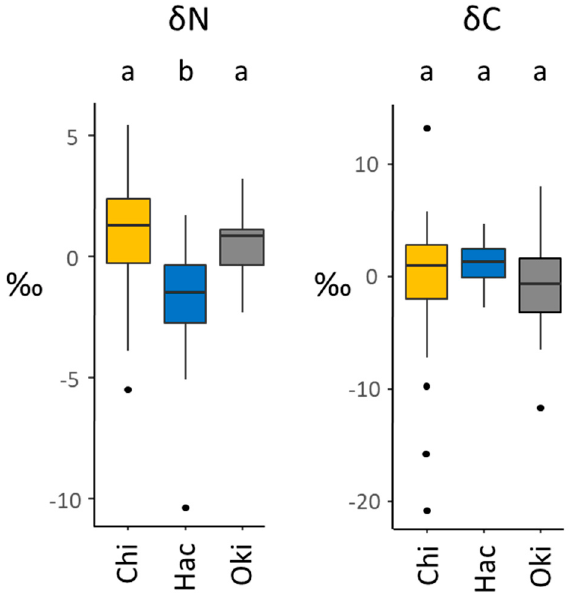
Figure 4. Boxplots of baseline-corrected natural isotope ratios for δ 15 N ( left ) and δ 13 C ( right ) for T. brunneus sampled from three island sites (Chi = Chichijima, Hac = Hachijojima, Oki = Okinawa) in parts-per-million. Letters above bars denote groups inferred by Dunn’s test. Boxes represent quartiles, the horizontal bar indicates the median, whiskers represent the minimum and maximum values, and points indicate outliers.